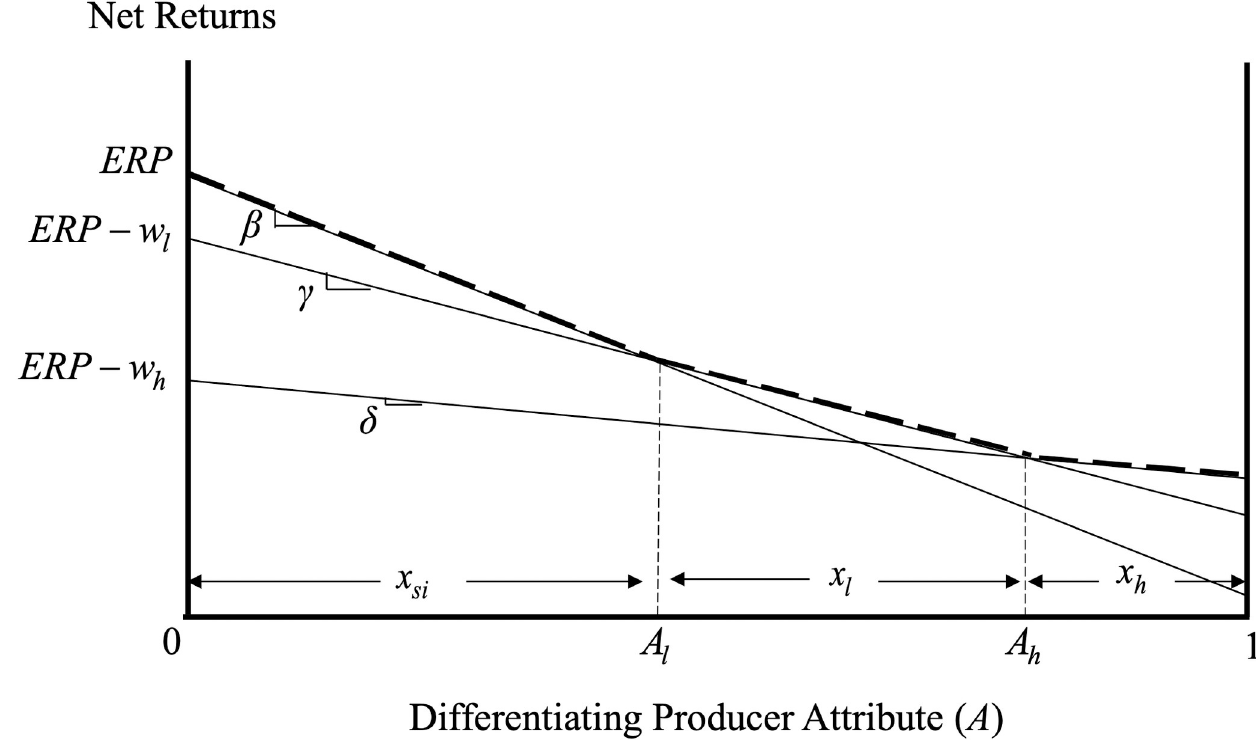
Fig 1. Producer insurance decisions and